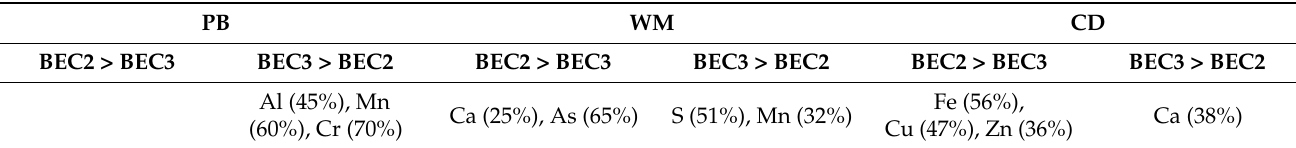
Table 9. Relative differences in the amounts of the element released into the atmosphere resulting from a comparison between the combustion